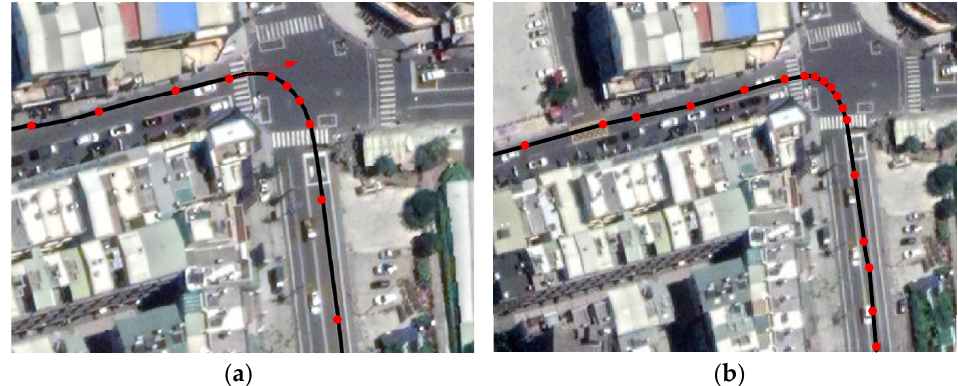
Figure 31. Variation in angular velocity of sampling points (vehicle speed of 40 km/h): ( a ) angular velocity change ( θ = ±300); ( b ) angular velocity change ( θ = ±150).